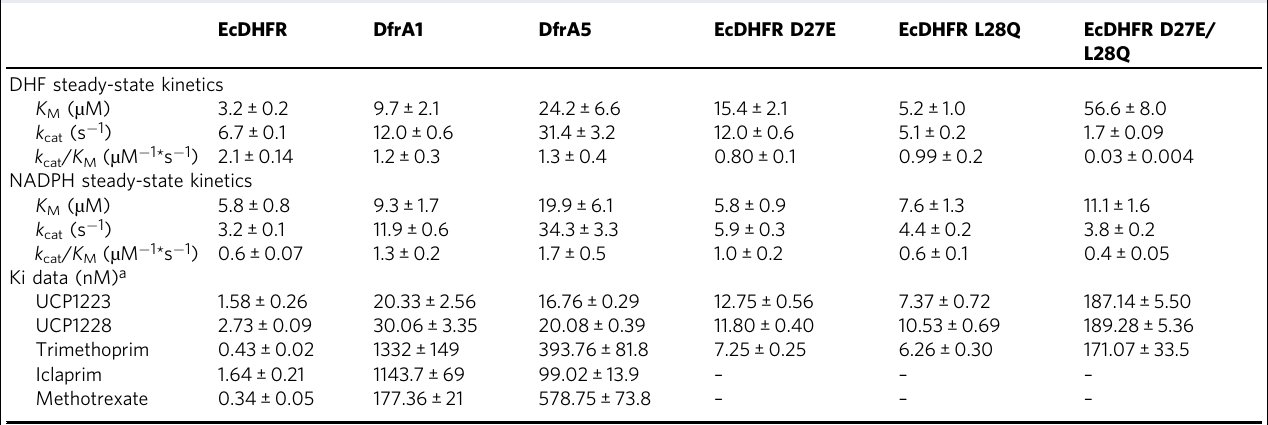
Methotrexate – – Kinetic and inhibition parameters are based on the rate of conversion of NADPH and DHF to NADP + and THF, monitored by the changes in the absorbance reading at 340nm. The kinetic constant, K M ( µ M)was generatedby fi ttinginitialvelocitydataasa function of DHForNADPHconcentrationtothe Michaelis – Mentenmodel.Thesamemodelwas usedtodetermine thecatalyticconstant k cat (s − 1 ) where the enzyme concentration was constrained to a constant value. Average values from triplicates with standard error for each parameter are shown. The inhibition constants (Ki) were derived from Cheng-Prusoff equation (Eq. 1). The kinetic data demonstrate decreased af fi nity for DHF and NADPH in DfrA enzymes, concomitant with an increase in rate of catalysis resulting in similar catalytic ef fi ciency. The inhibition data reveals a high level of resistance for clinical antifolates. a Calculated as K i = IC 50 /(1 + [S]/ K M ) (Eq. 1).